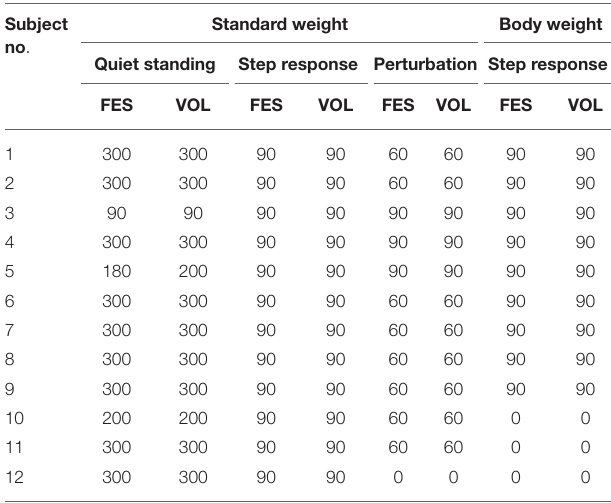
FES, FES controlled balance; VOL, disrupted voluntary control of muscle